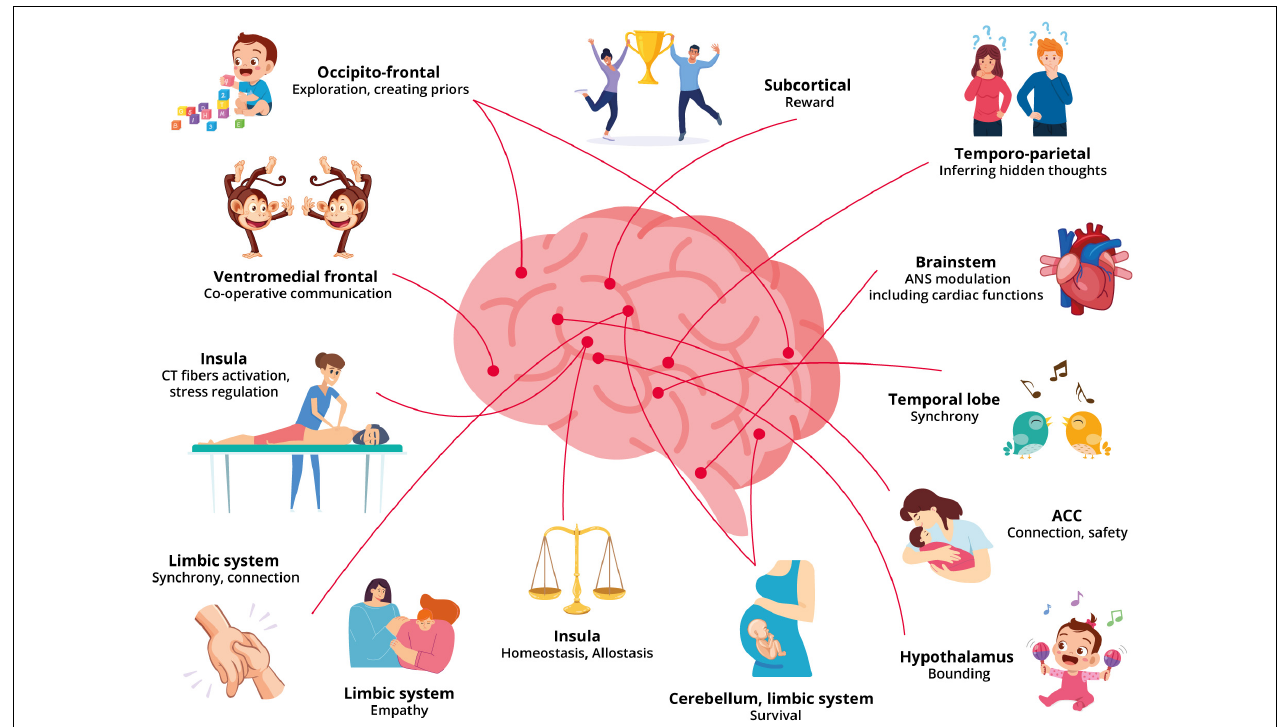
FIGURE 1 | An overview of the effects of touch and therapeutic alliance on the different networks of the